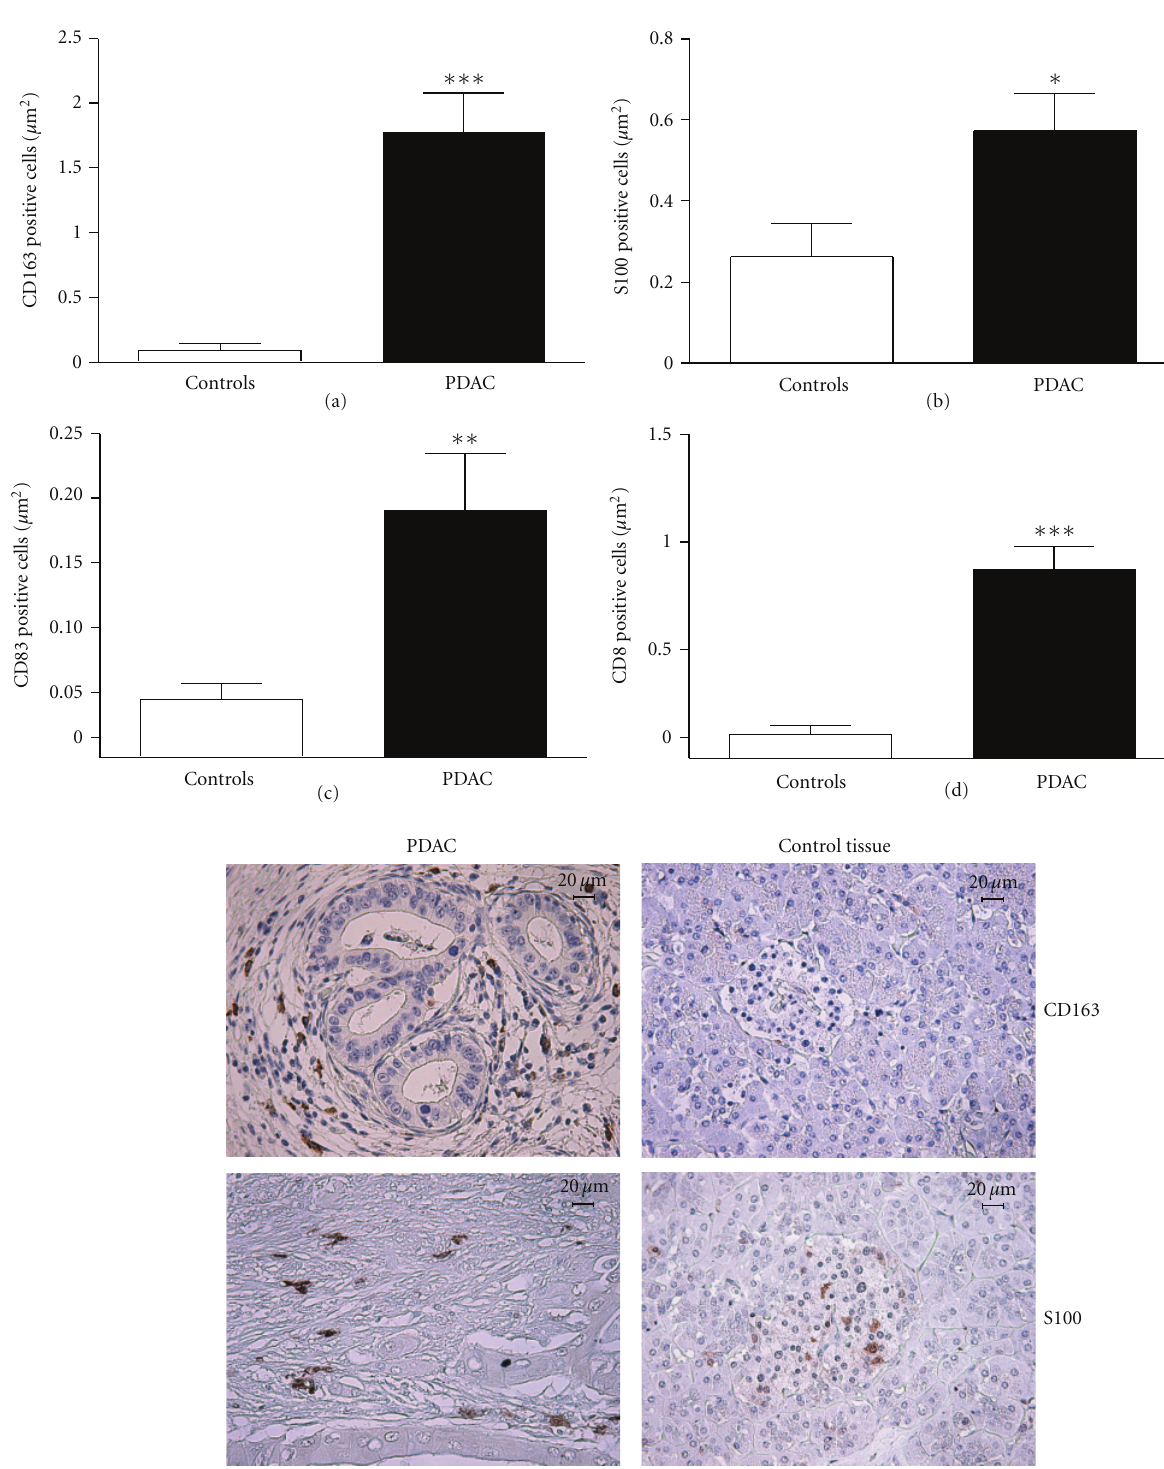
Figure 5: PDAC tissues show infiltration of immune cells such as macrophages, dendritic cells, and CTLs. PDAC and healthy pancreatic tissue samples were immunohistochemically stained with anti CD163, S100, CD83, and CD8 antibodies (abs) followed by biotin-conjugated secondary abs and streptavidin-HRP complex. Peroxidase was detected using DAB chromogen. The amount CD163 (a), S100 (b), CD83 (c), and CD8 (d) positive cells/ μ m 2 were calculated from 20 randomly selected fields using a computerized image processing analysis system linked to a microscope. (e) The micrographs show expression and location of CD163, S100, CD83, and CD8 positive cells in the PDAC and healthy pancreatic tissues. Size bar 20 μ m. ∗ P < 0 . 05, ∗∗ P < 0 . 05, ∗∗∗ P < 0 .